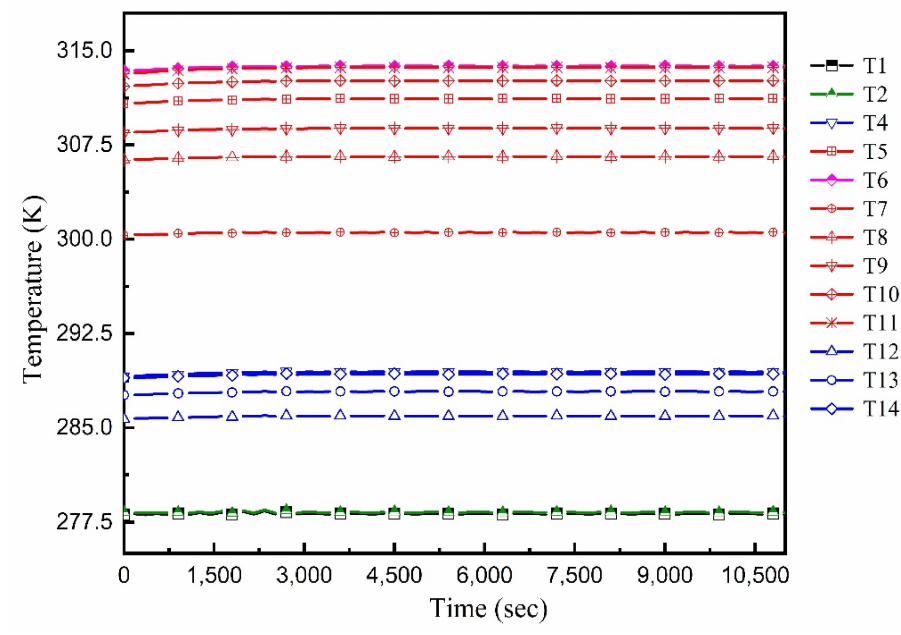
Figure 8. Variations in surface temperature measurements during data